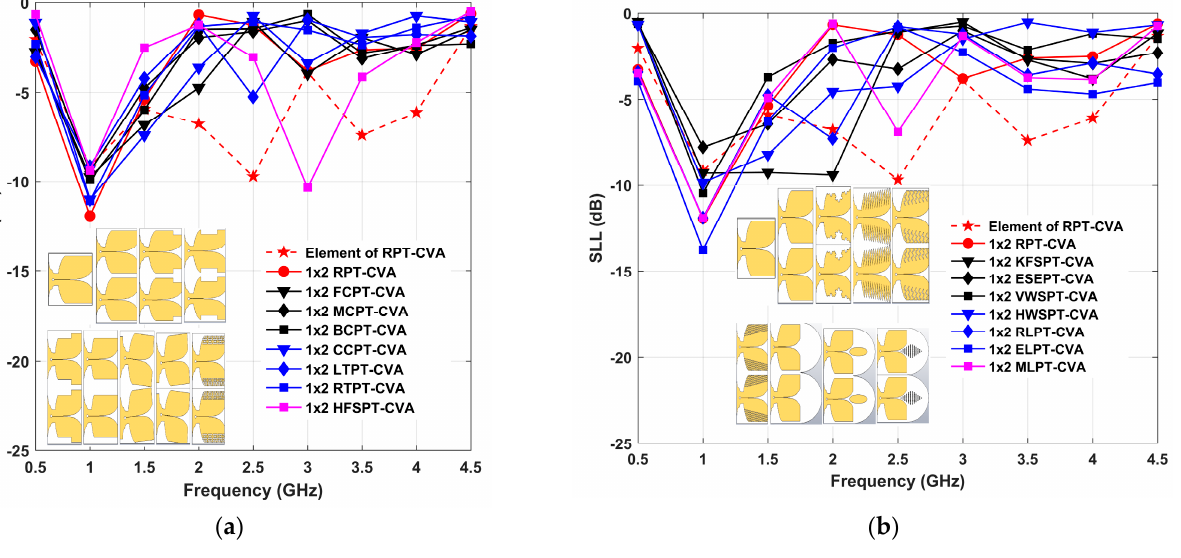
Figure 8. Side Lobe Level of ( a ). Element and 1 × 2 Regular Palm Tree (RPT ‐ CVA), 1 × 2 Front Cut Palm Tree (FCPT–CVA), 1 × 2 Middle Cut Palm Tree (MCPT–CVA), 1 × 2 Back Cut Palm Tree (BCPT–CVA), 1 × 2 Complete Cut Palm Tree (CCPT–CVA), 1 × 2 Left Tilt Palm Tree (LTPT –